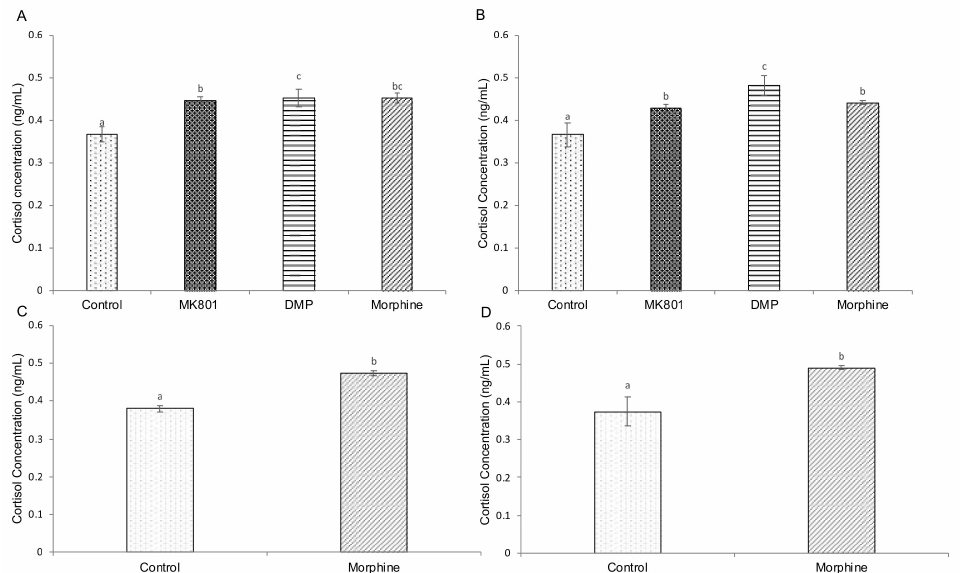
Figure 4. Effects of ( A ) short-term (F (3,32) = 22.035, p < 0.001) and ( B ) long-term (F (3,32) = 108.164, p < 0.001) exposure to MK801, DMP and morphine, and ( C ) short-term ( t (16) = 12.465, p = 0.003) ( D ) and long-term ( t (16) = 9.964, p = 0.029) morphine withdrawal on whole-body cAMP concentration (ng/mL) in zebrafish larvae. Data expressed as mean ± SEM, n = 50 of 3 independent experiments. Different lowercase letters indicate statistically significant values, p < 0.05. DMP: